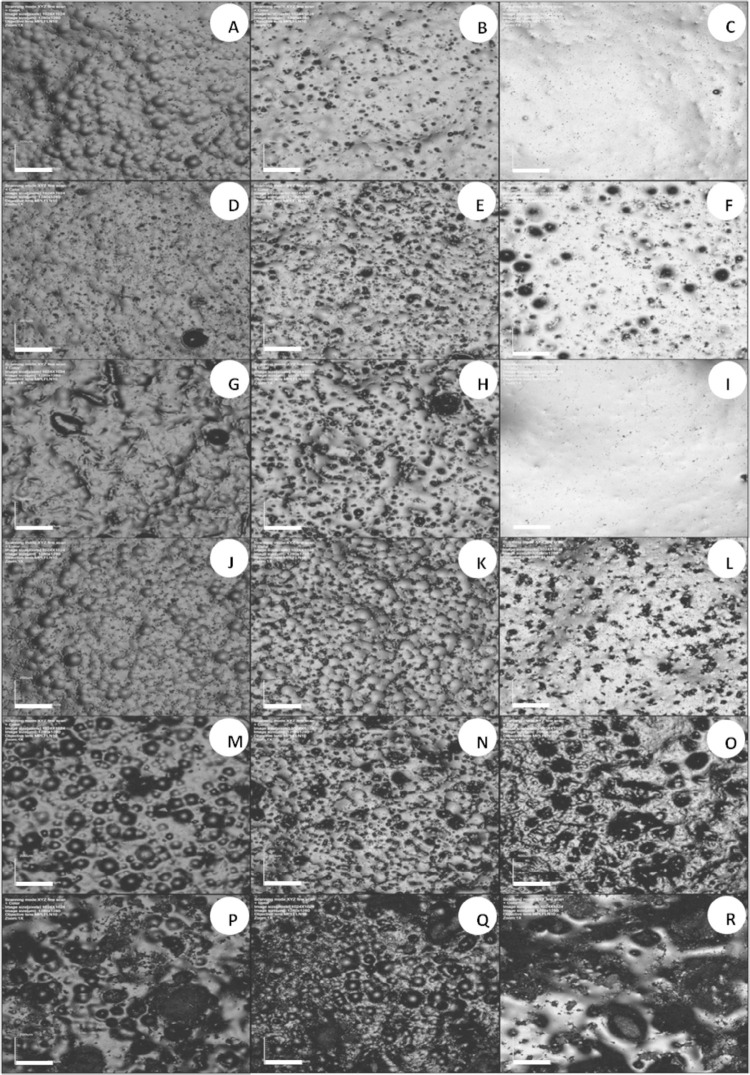
CLSM images of resilient liner Trusoft at 24-h (1st column), 7-day (2nd column), and 14-day intervals (3rd column). A to C – control; D to F – Ny; G to I – Mc; J to L – Ke; M to O – Chx; and P to R – It. Scale bar = 200 µm (Magnification 10x)